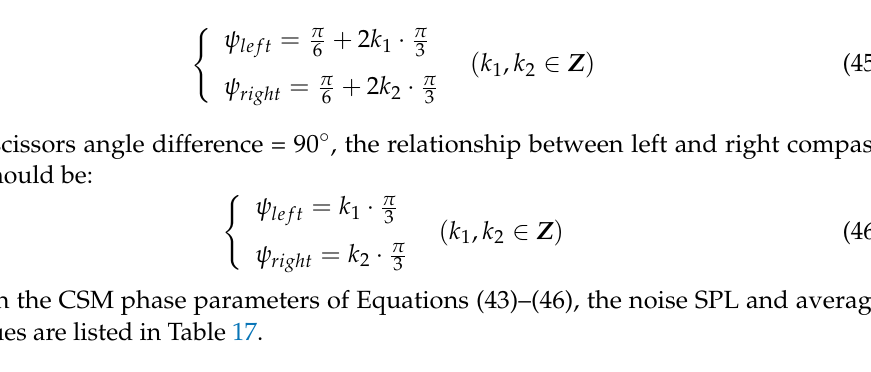
Table 17. Noise SPL and average RCS values with CSM phase parameters of Equations (43)–(46). Helicopter